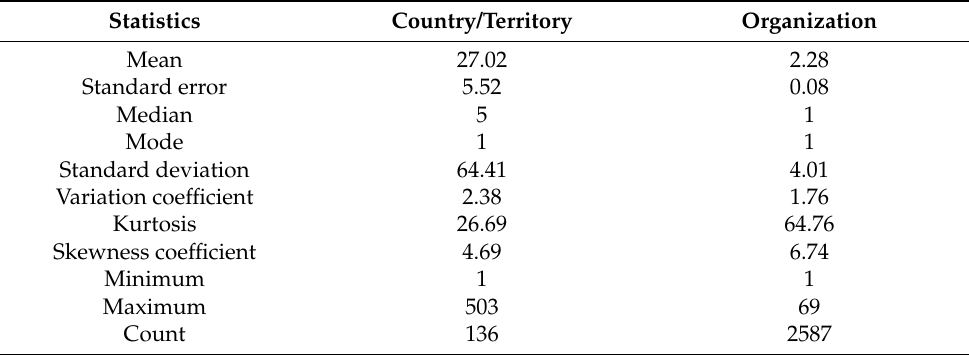
Table 2. Main global references to territorial and organizational contribution on coastal governance studies (1978 – 2021).